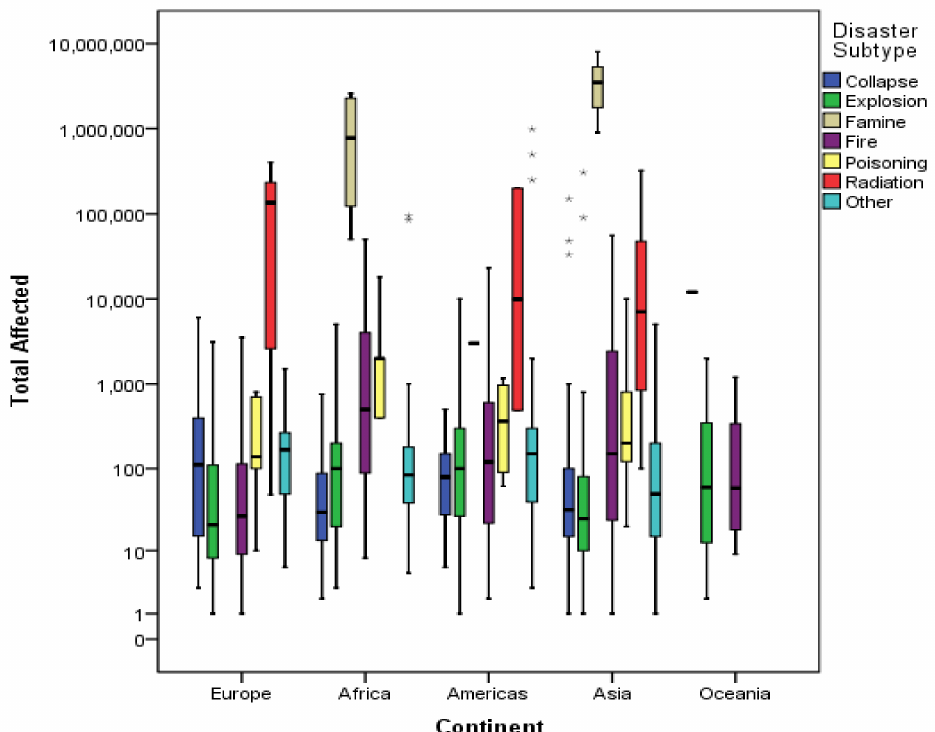
Figure 4. Box plots of total number of affected persons according to the disaster subtype and the continent where the disaster occurs. (Note: * = extremely